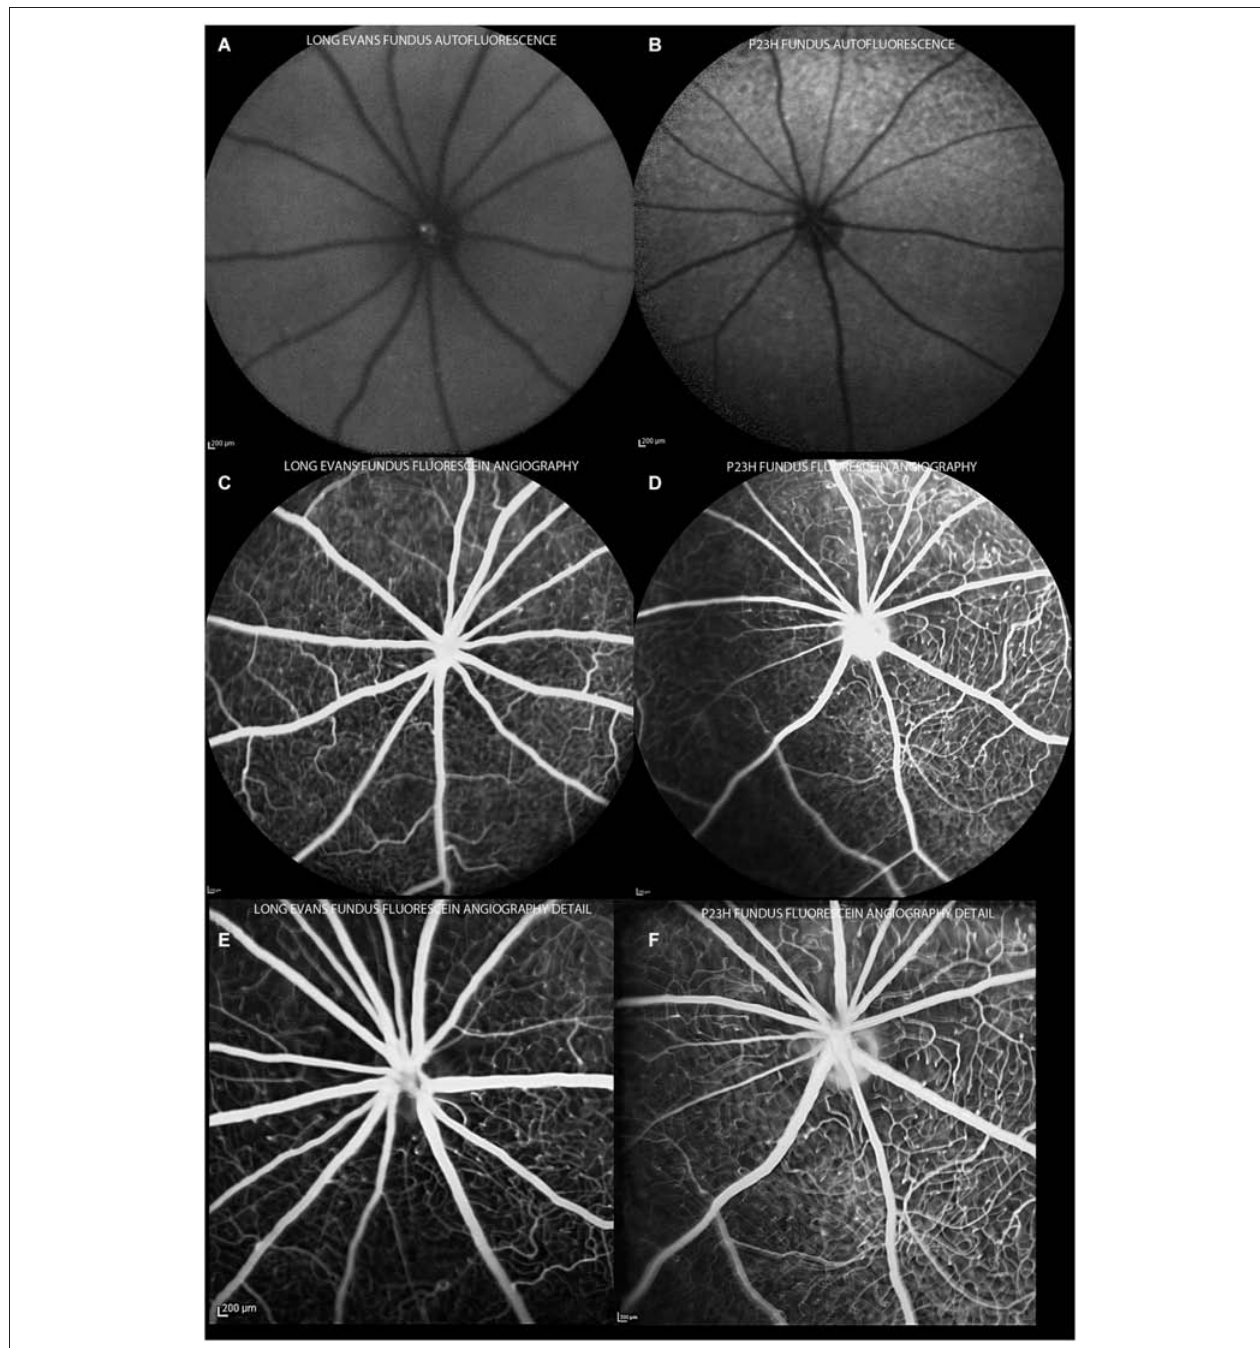
degenerative rats (B) . Angiograms of control (C,E) and P23H rats (D,F) , showing a normal radial pattern and capillary network at this